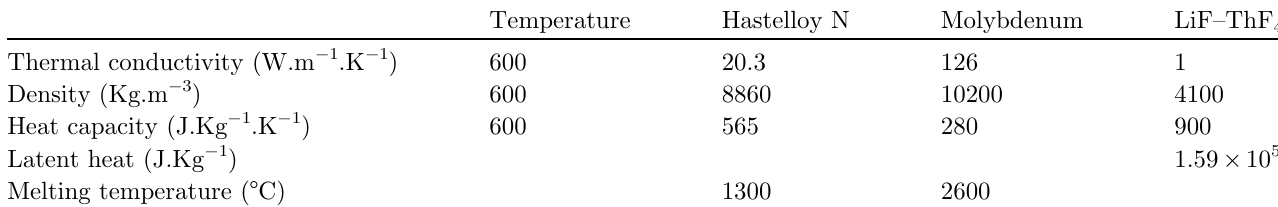
Table 2. Data used for the reactor cold plug simulation.